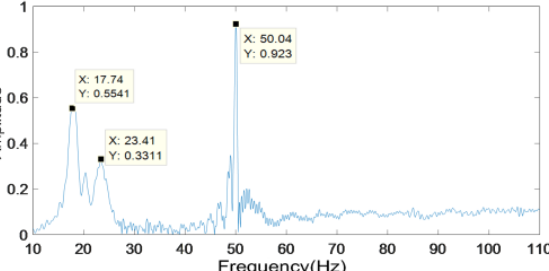
Figure 29. FFT of current i ga at different impedance of the transmission line in PI.